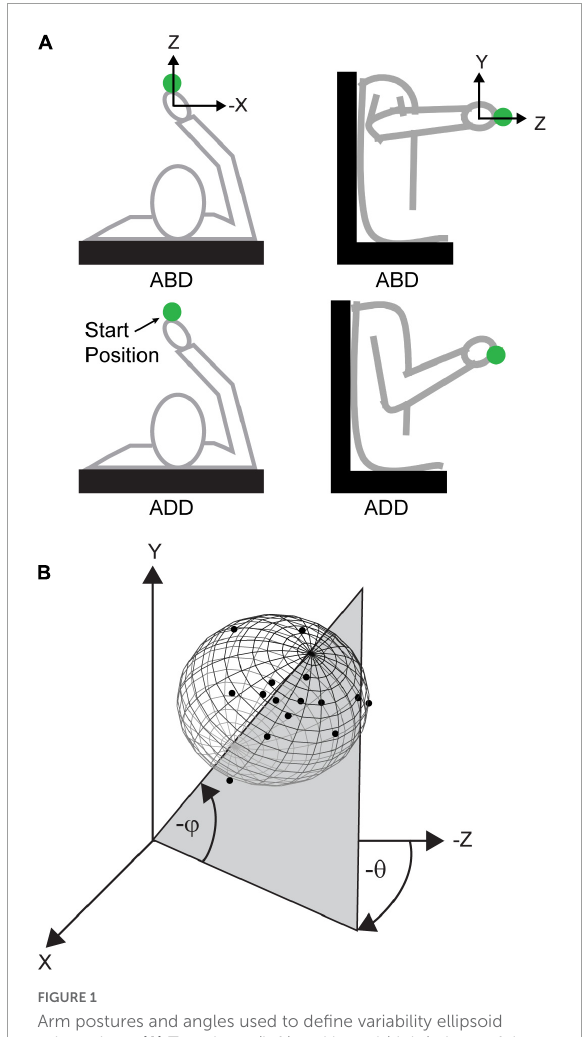
FIGURE1 Arm postures and angles used to define variability ellipsoid orientations. (A) Top-down (left) and lateral (right) views of the abducted (ABD) and adducted (ADD) postures. (B) Simulated 3D endpoint distribution showing definitions for azimuth ( θ ) and elevation ( ϕ ). Azimuth was defined as the angle in the x-z plane and was positive going from the negative z -axis toward the negative x -axis. Elevation was defined as the angle from the x-z plane and was positive going toward the negative y